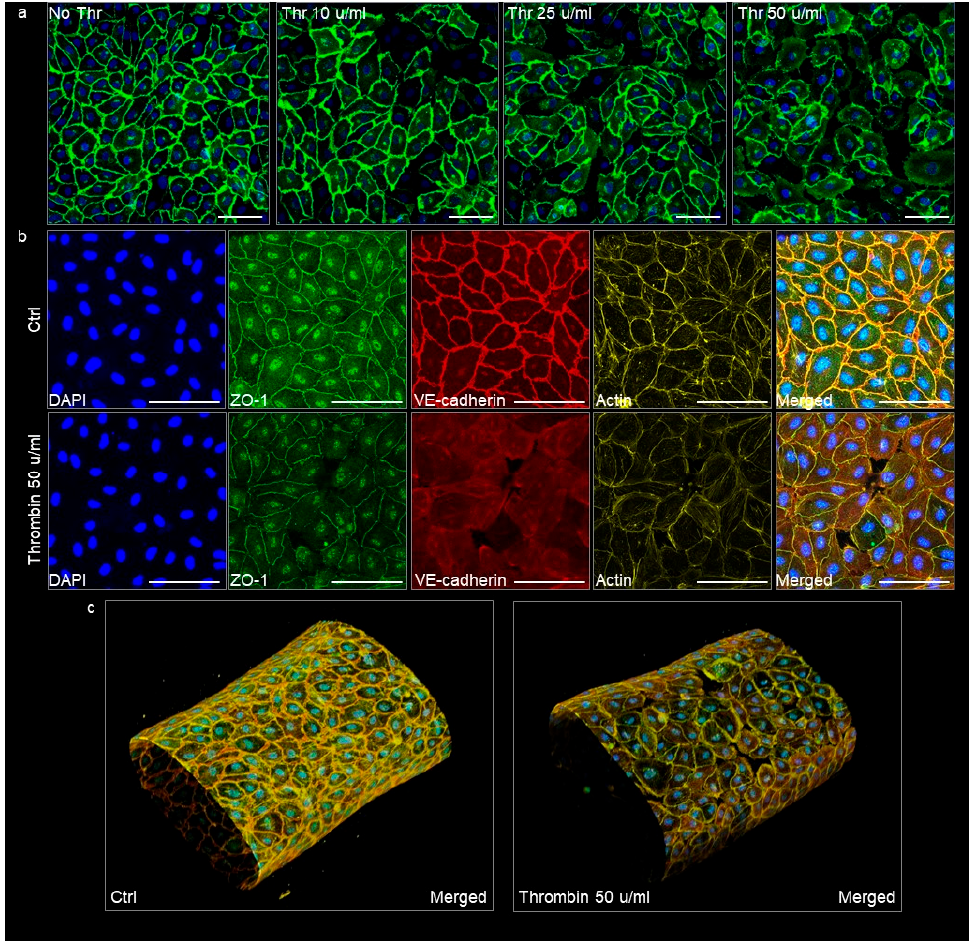
Figure 8. Confocal images of VoC immunostained after the permeability assays. ( a ) VoC treated with increasing amounts of thrombin were immunostained for the adherens junction molecule VE- cadherin (green) and nuclei were stained with DAPI (blue). ( b ) VoC treated or not with 50 µ/mL thrombin were stained for nuclei (DAPI), the tight-junction molecule ZO-1, the adherens junction molecule VE-cadherin, and for actin. Maximum intensity projection of the z -axis. Ctrl—untreated VoC; Thr—thrombin, bars = 100 µm. ( c ) 3D reconstructions of VoC, merged staining as in ( b ).